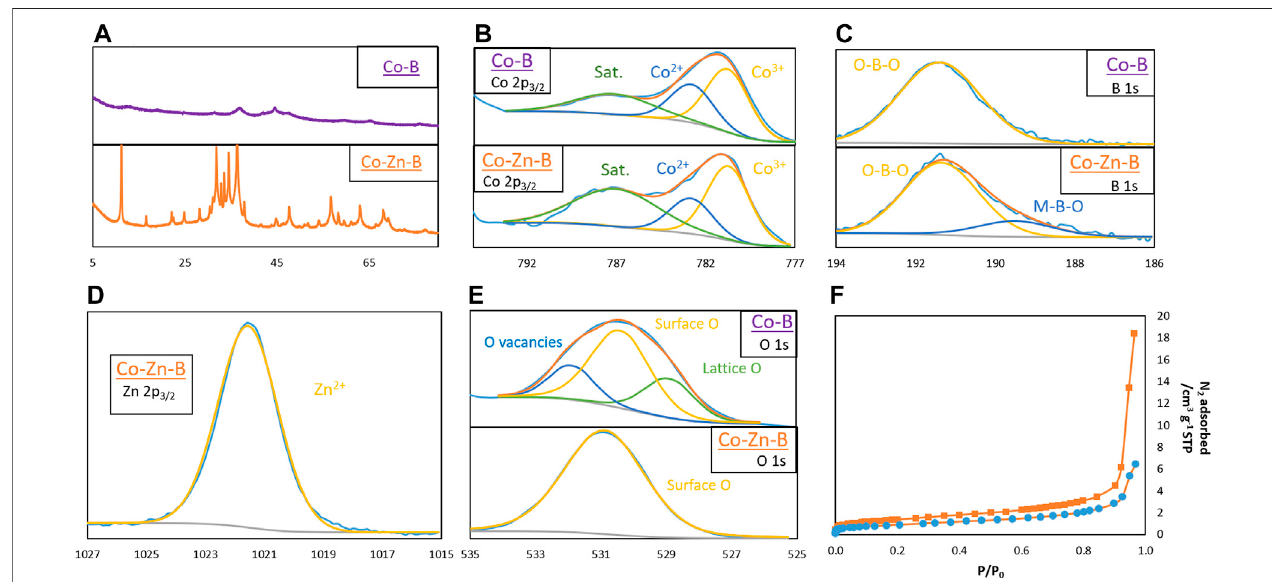
FIGURE 3 | (A) XRD pattern of Co-B (top) and Co-Zn-B (bottom). (B) XPS spectra of Co 2p 3/2 Co-B (top) and Co-Zn-B (bottom). (C) XPS spectrum of Zn 2p 3/2 of Co-Zn-B. (D) XPSspectraofB1sofCo-B(top)andCo-Zn-B(bottom). (E) XPSspectraofO1sofCo-B(top)andCo-Zn-B(bottom). (F) N 2 -absorptionisothermsofCo- B (purple) and Co-Zn-B (orange).